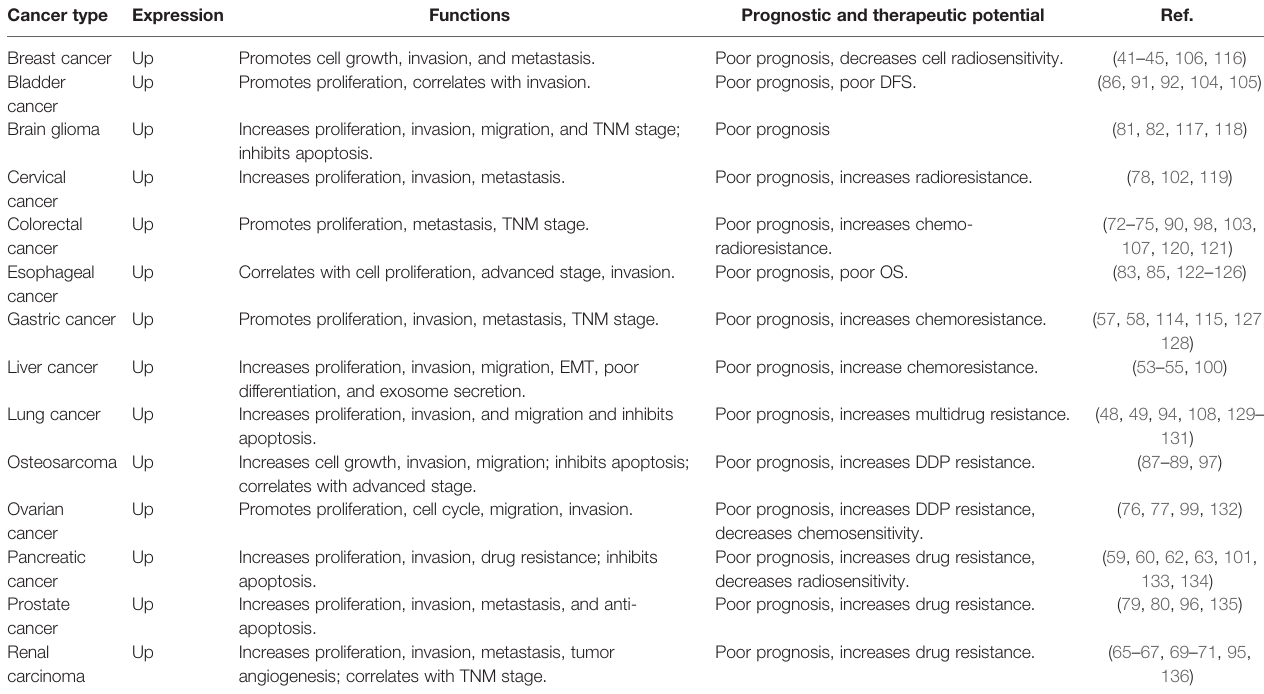
TABLE 1 | HOTAIR expression, functions, and prognostic and therapeutic potential in different human cancers. Cancer type Expression Functions Prognostic and therapeutic potential Ref. Breast cancer